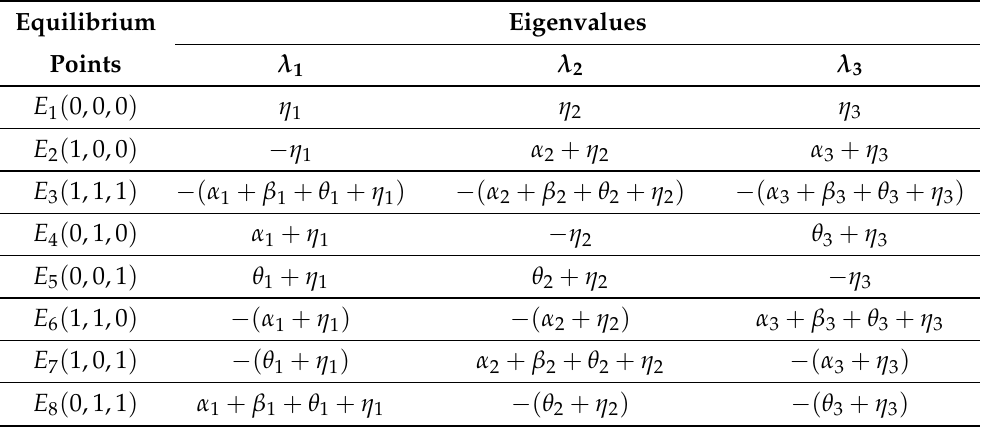
Table 3. The pure strategy equilibrium points and